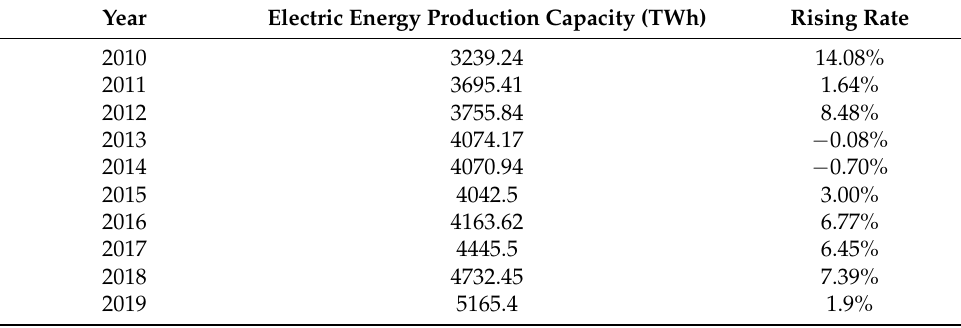
Table 5. Coal power generation and rising rate from 2010 to